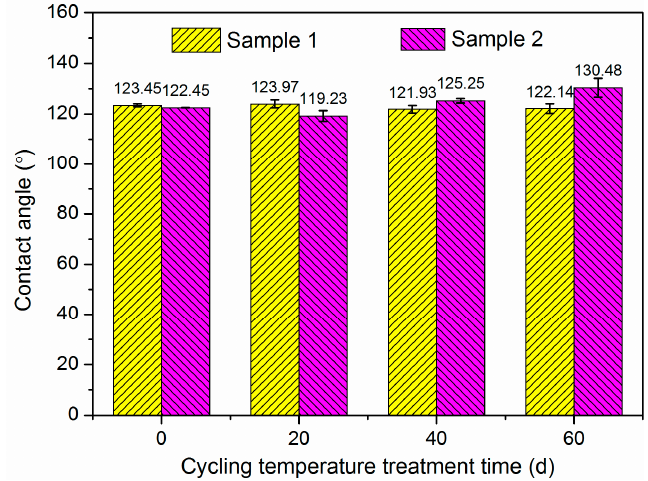
Figure 5. Contact angle of virgin samples and samples at different aging times.